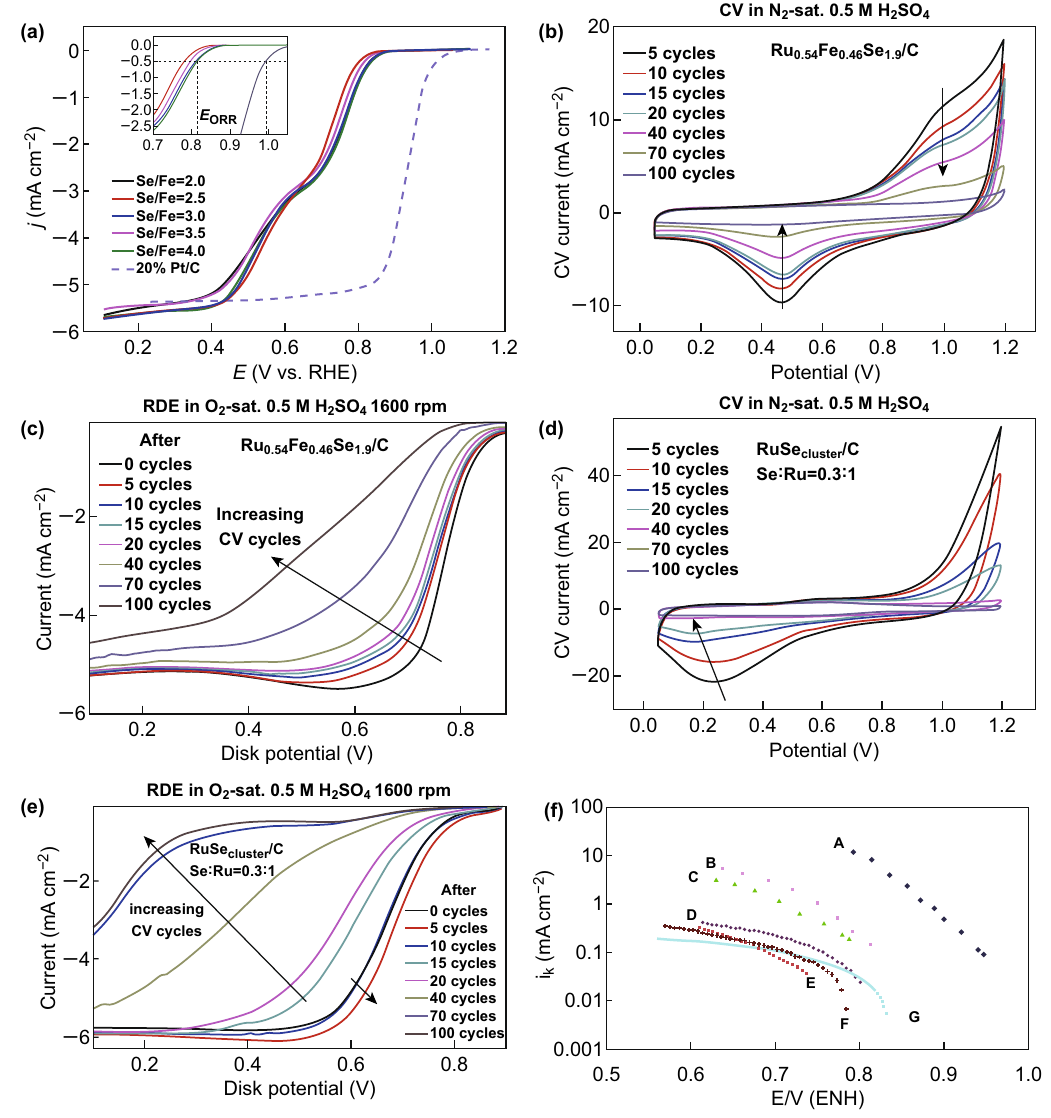
Fig. 12 a RDE polarization curves of Pt/C (dashed line) and FeSe 2 /C (solid lines) prepared with different Se/Fe ratios in O 2 saturated 0.1 mol L −1 KOH solution at 1600 rpm. b CV scan was subjected to electrocatalyst stability test at 50 mV sL −1 . c Electrocatalyst stability tests O 2 reduction current at 10 mV sL −1 and 1600 rpm was Ru 0.54 Fe 0.46 Se 1.9 /C. d CV scan was subjected to electrocatalyst stability test at 50 mV sL −1 . e Electrocatalyst stability test O 2 reduction current of RuSecluster/C (Se:Ru = 0.3:1) at 10 mV sL −1 and 1600 rpm. f ORR Tafel graphs. Adapted from Refs. [109–111] with permission. Copyrights: 2015, The Royal Society of Chemistry and 2009 (2010),